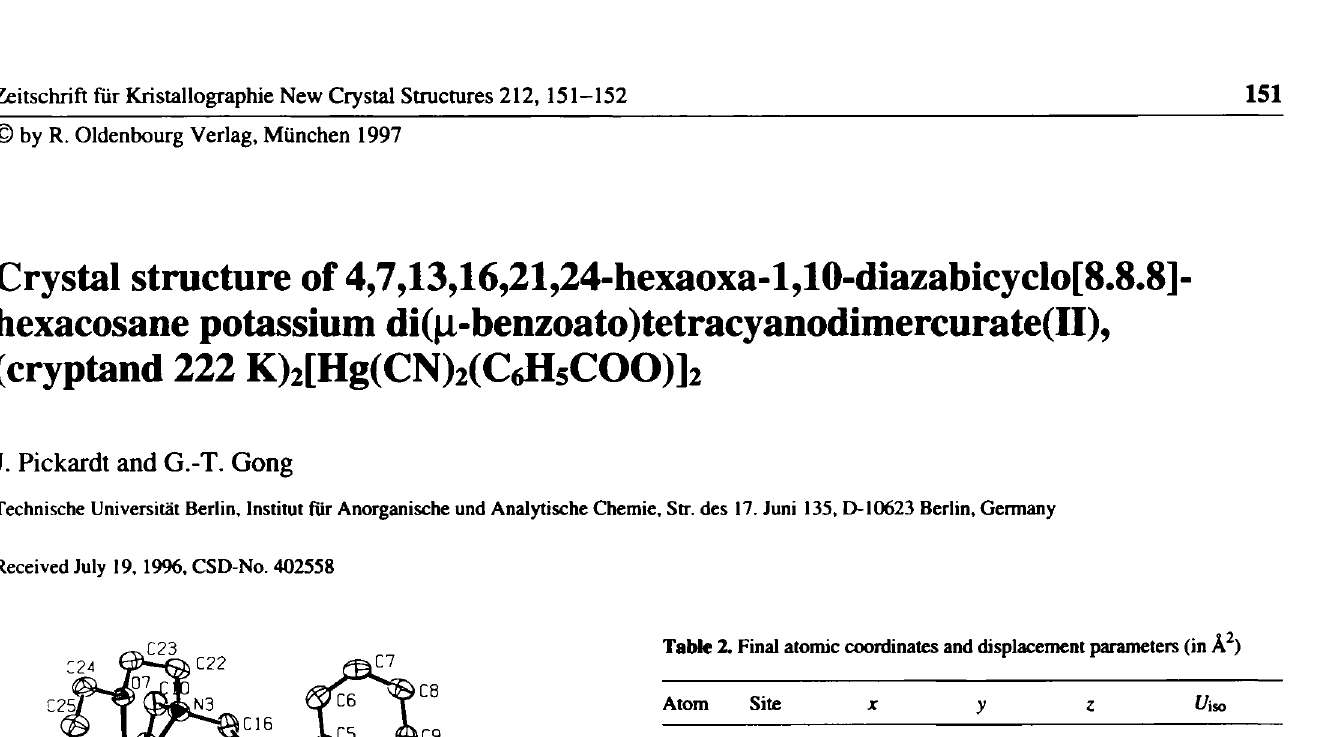
Table 2. Final atomic coordinates and displacement parameters (in Â 2